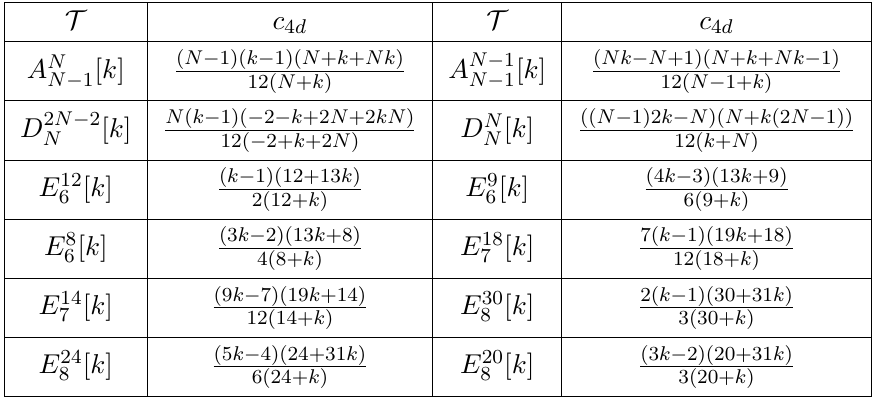
Table 3 . Central charges for the AD theories without (cid:13)avor symmetries. Note that this formula is only true for certain choice of k and N so that the irregular puncture is irreducible.